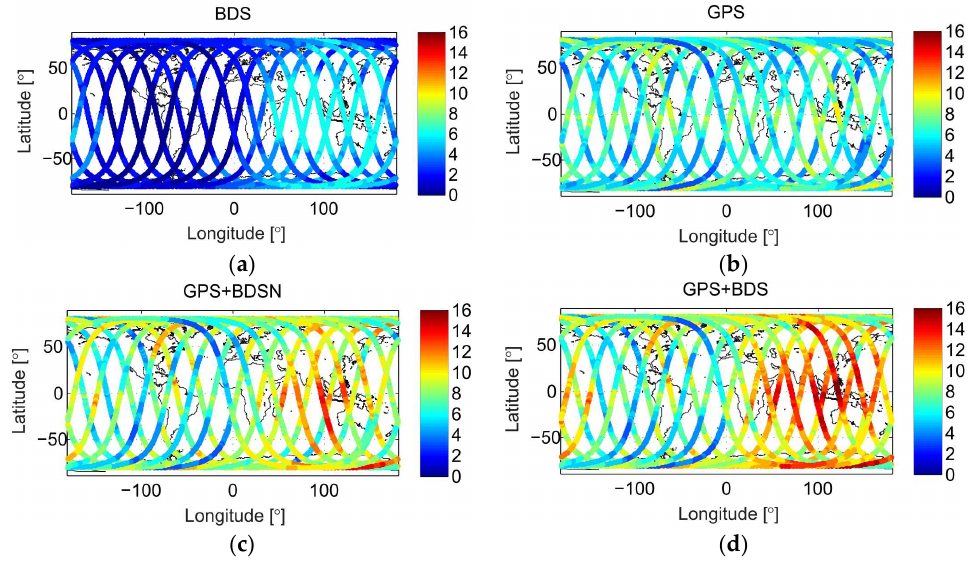
Figure 6. Number of tracked GPS/BDS satellites: ( a ) BDS-alone; ( b ) GPS-alone; ( c ) GPS and BDS IGSO/MEO fusion; ( d ) GPS and BDS fusion.